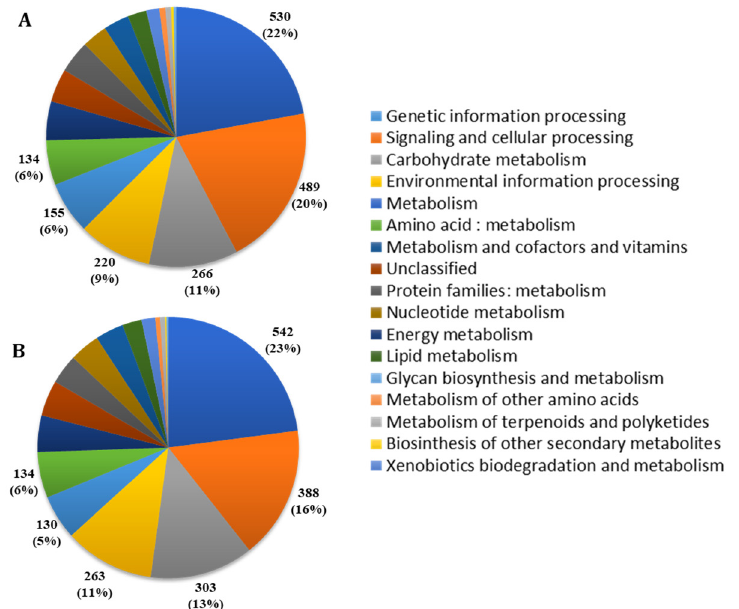
Figure 4. Genome annotation of SF106 ( A ) and SF174 ( B ) by BlastKOALA Kyoto Encyclopedia of Genes and Genomes (Kegg). The total number and the relative percentage of proteins assigned to the most abundant categories are indicated. Table 2. Number of putative genes for the CAZymes categories in SF106, SF174 and selected probiotic strains of the respective species.